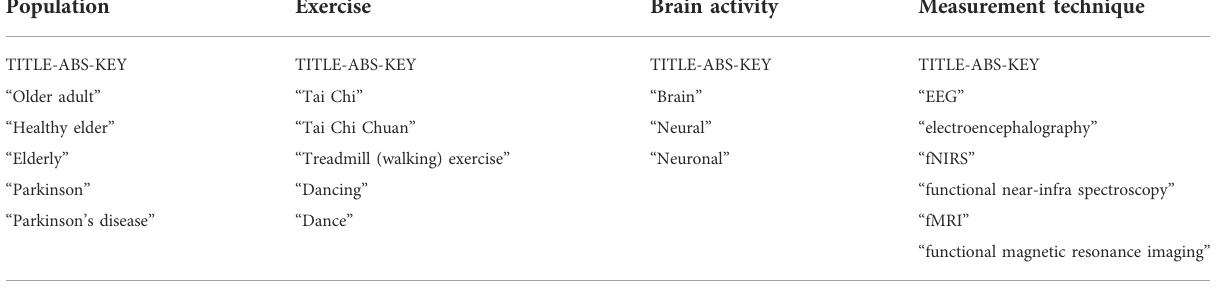
TABLE 1 Key search words and synonyms used for each search fi eld.